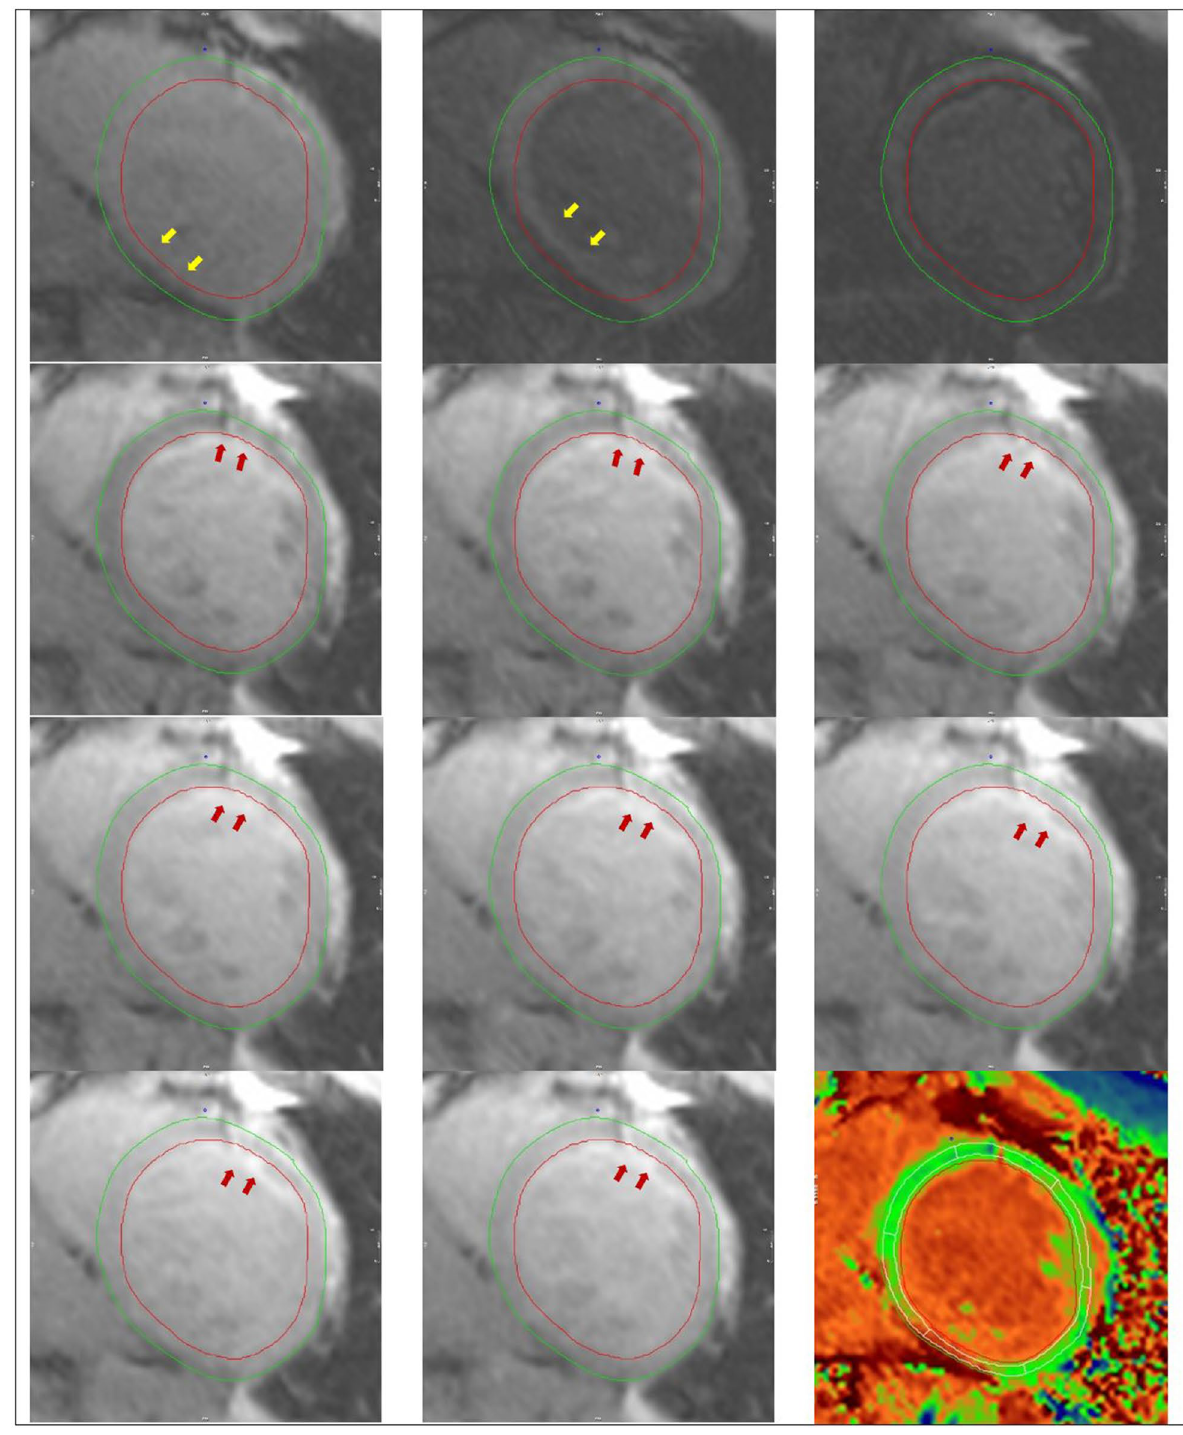
Figure 5. Illustration of (1) susceptibility artefact originating from the epicardial fat (red arrows), and (2) motion correction artefact (yellow arrows) on individual MOLLI acquisition images, with their resulting effects on the T1 map (bottom right). The position and shape of epicardial and endocardial contours across acquisiton images have been kept identical to help highlight myocardial